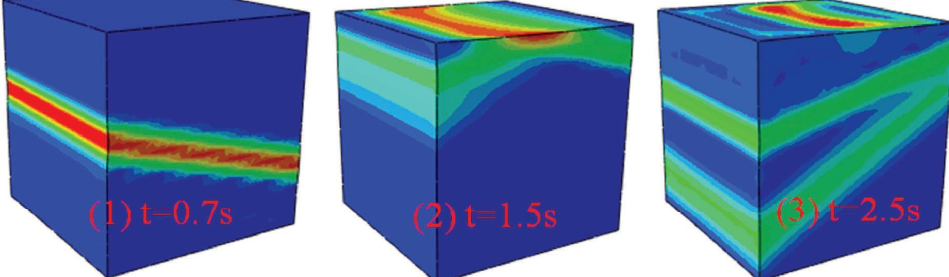
Figure 4: SV wave 15 ° cloud map of half-space displacement feld at oblique incidence.